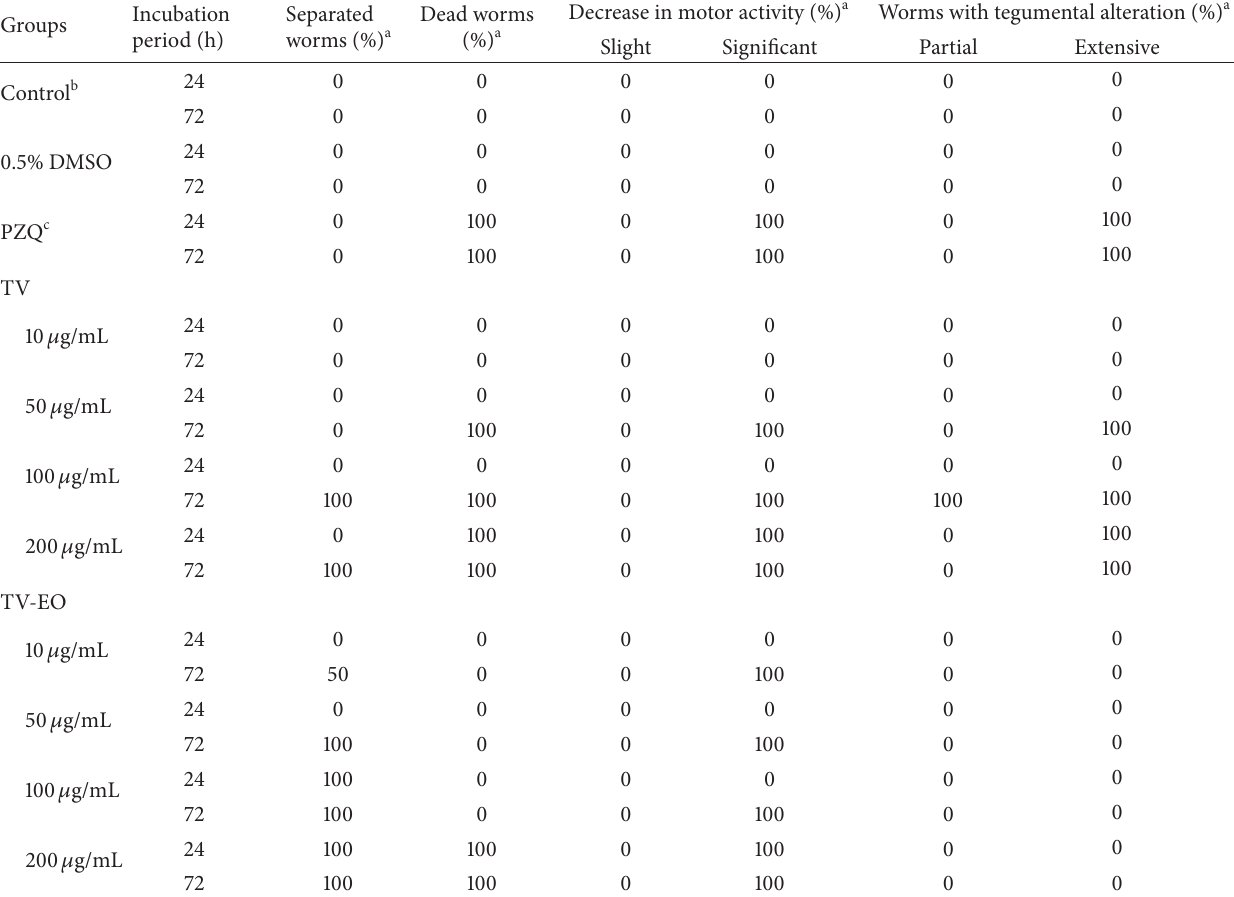
Table 1: In vitro effects of crude hydroalcoholic extract (TV) and essential oil of T. vulgare (TV-EO) against S. mansoni adult worms. Dead worms Decrease in motor activity (%) a Worms with tegumental alteration (%) a Incubation Separated Groups period (h) worms (%) a Significant Partial Extensive Control b